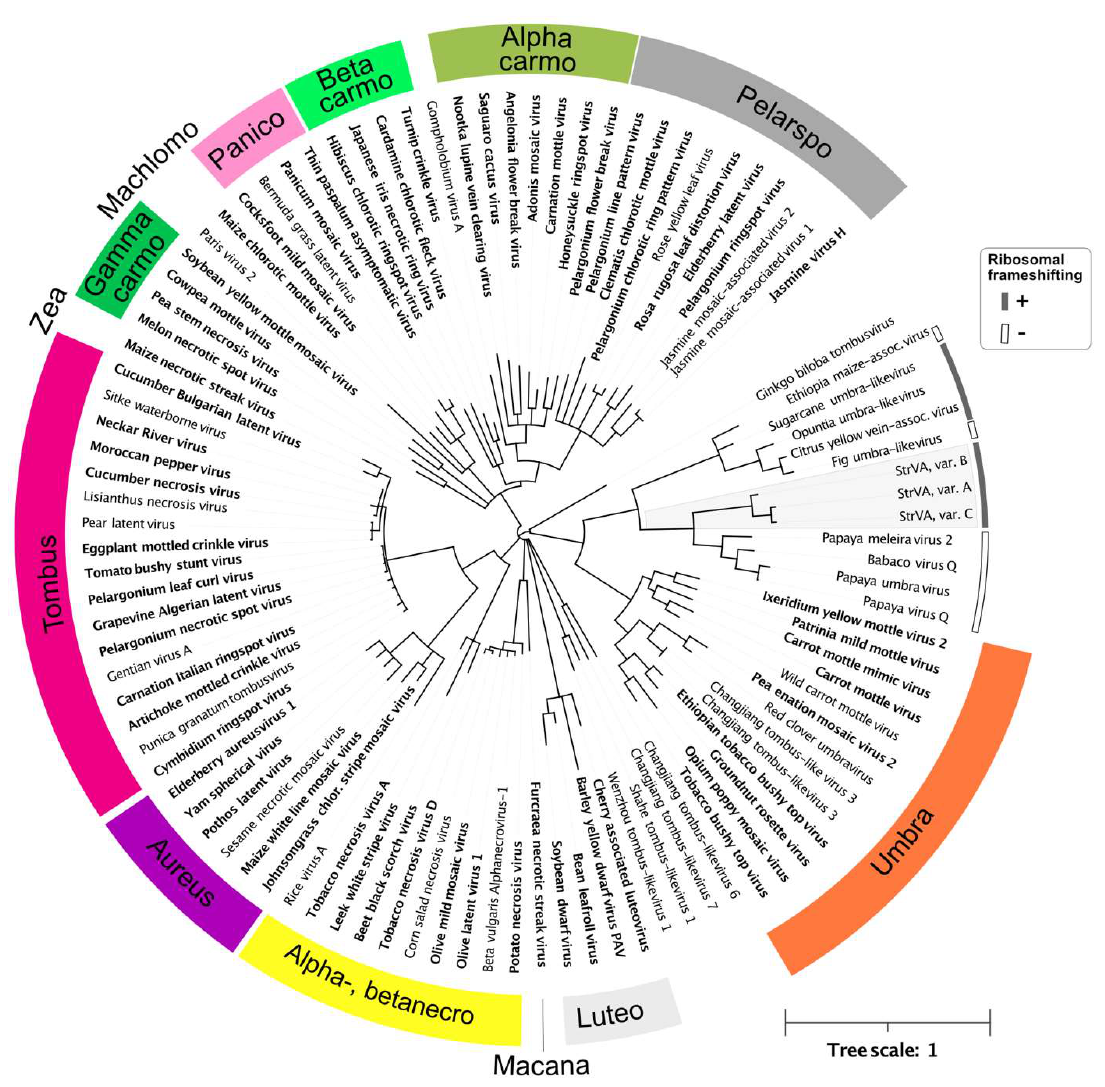
Figure 4. Phylogeny of StrVA, tombusviruses, and other related viruses based on the RNA polymerase protein. All branches with less than 0.9 support are collapsed. The scale is shown in the lower right corner. Viruses officially recognized as species by ICTV are in bold; genera are color-coded. The accession numbers of the sequences used are shown in Table S1. For StrVA and related viruses, putative ribosomal frameshifting is annotated as shaded or unshaded arcs.